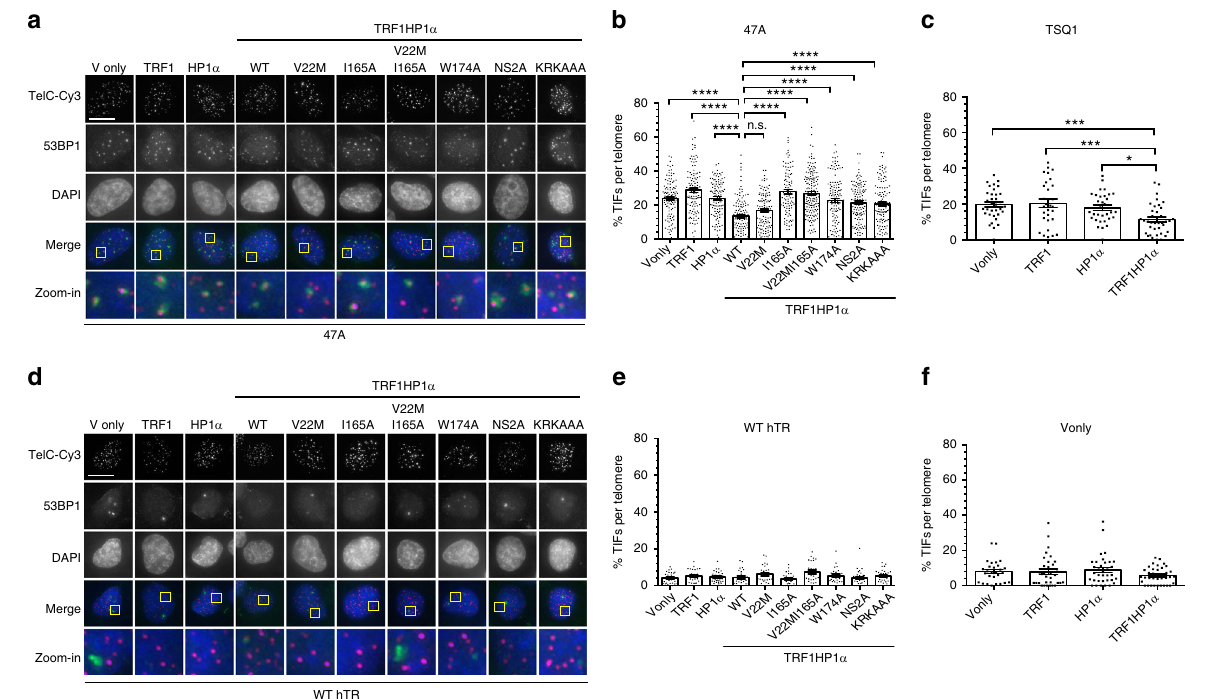
Fig. 4 TRF1HP1 α results in reduced TIFs induced by mutant hTR expression. Cells stably expressing TRF1HP1 α (WT or mutant variants of HP1 α ) were infected with lentivirus containing WT hTR, or mutant hTR (47A or TSQ1) on day 0, selected for stable expression after 48 h, and analyzed on day 5. a Fluorescence microscopy images of representative cells expressing mutant hTR 47A stained with telomeric (Tel-Cy3) peptide nucleic acid (PNA) probes (magenta in merged image) via fl uorescent in situ hybridization (FISH), antibody against DNA-damage repair protein marker 53BP1 (green in merged image), and counterstained with DAPI. Zoom-in images (the last row) correspond to yellow-squared regions of the row above. b % TIF per telomere of each nucleus is quanti fi ed; n = 94 – 159 nuclei combining data of three independent experiments. **** p < 0.0001; n.s. (no signi fi cance). a , b Scale bar: 10 µ m. c Upon TSQ1 expression, TRF1HP1 α results in fewer TIFs compared to Vonly, TRF1 or HP1 α controls. TRFHP1 α ~11.4% shows decreased TIFs compared to Vonly: ~19.7% *** p = 0.0008; TRF1: ~20.4% *** p = 0.0005; HP1 α : ~17.9% * p = 0.0137 ( n = 30 – 38 nuclei). b , c Signi fi cance is assessed by one-way ANOVA and Dunnett ’ s multiple comparison test with 95% con fi dence level. d Fluorescence images of control cells overexpressing WT hTR ( n = 27 – 36 nuclei). Same color scheme as a . TIFs quanti fi cation in the presence of e WT hTR or f Vonly ( n = 28 – 36 nuclei) show minimal baseline DNA damage at telomeres. b , c ; e , f Error bars represent s.e.m.